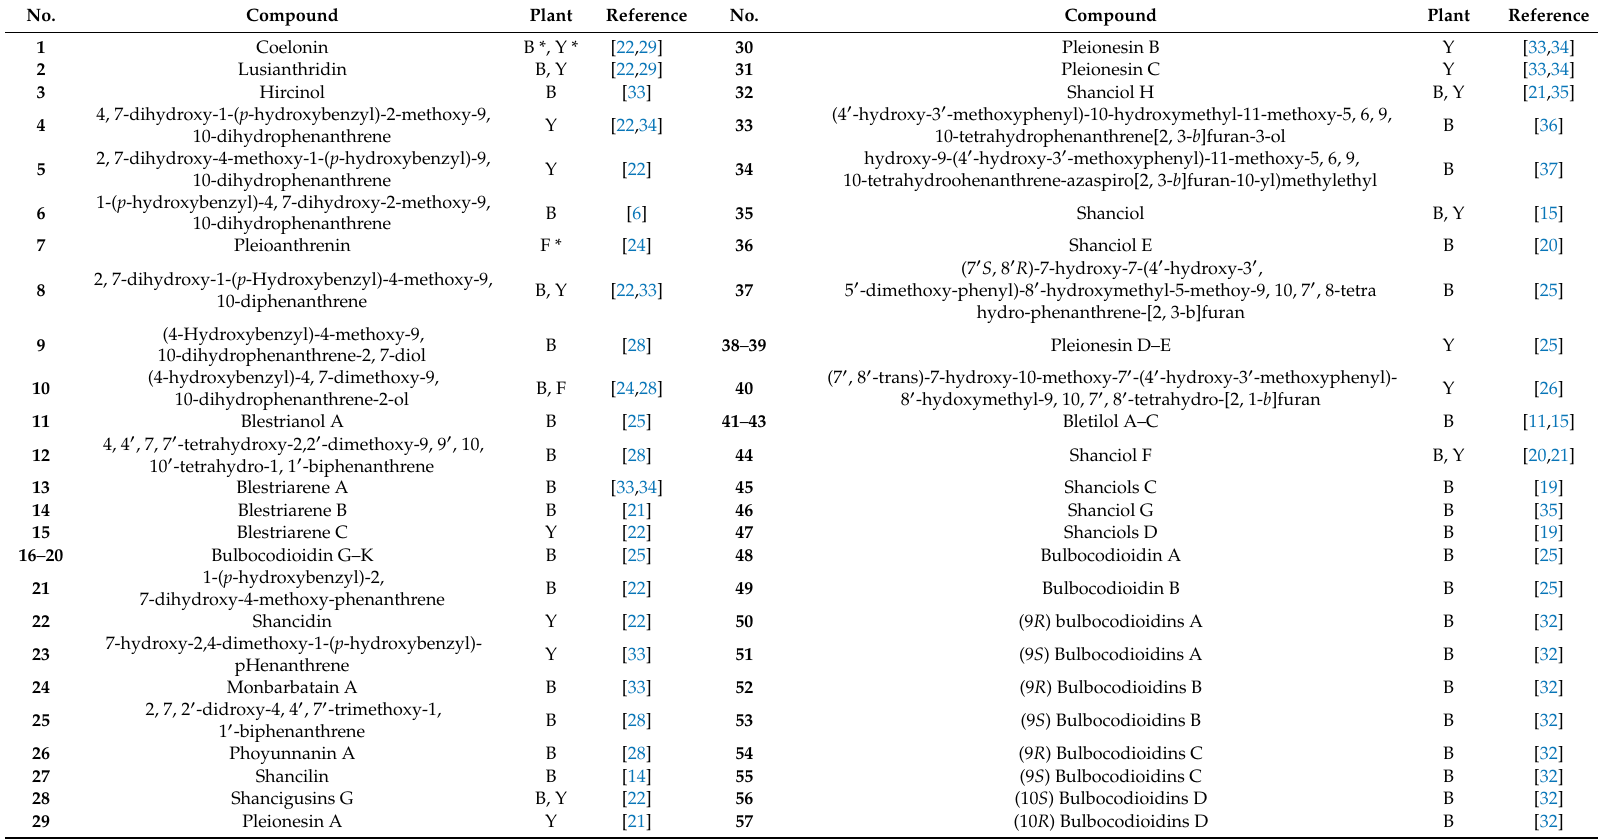
Table 1. Phenanthrenes from Pleione